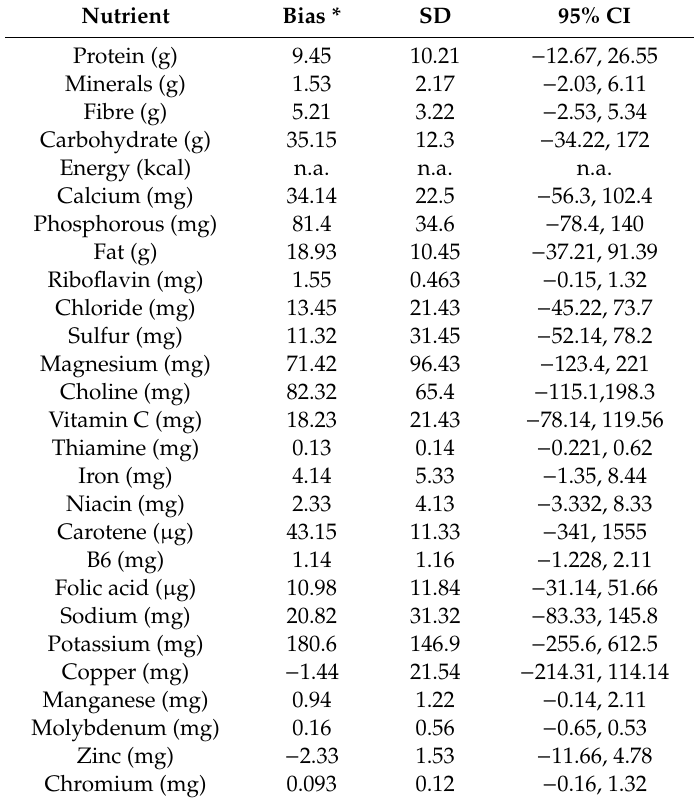
Table 4. Bland–Altman analysis of nutrients between the FFQ and 7-day food diary.